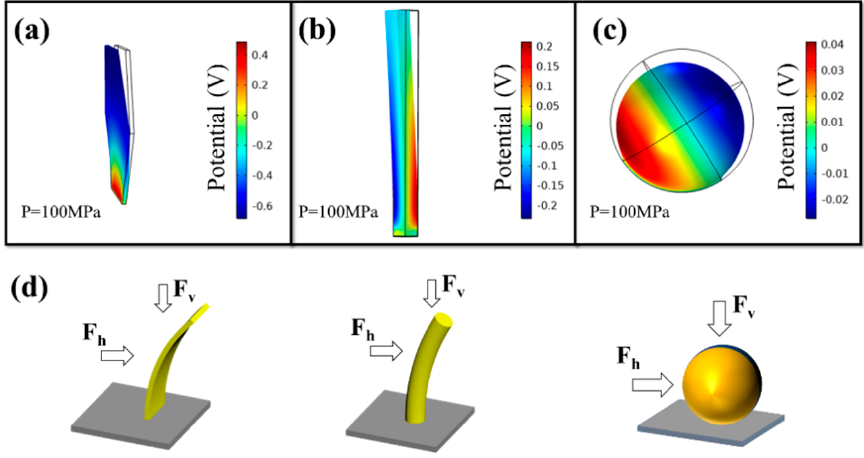
Figure 10. ( a – c ) The FEM simulation for the piezoelectric potential distribution in the three ZnO samples with pressures of 100 MPa. ( d ) Schematic of deformation of ZnO under ultrasonic vibra- tions.